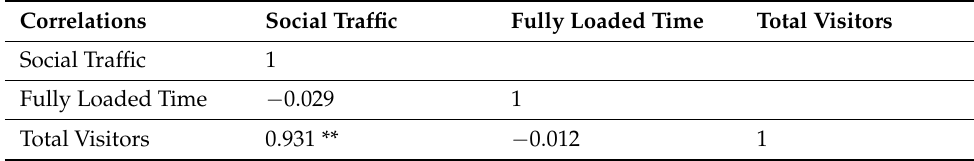
Table 5. Coefficients between the examined metrics for H2.